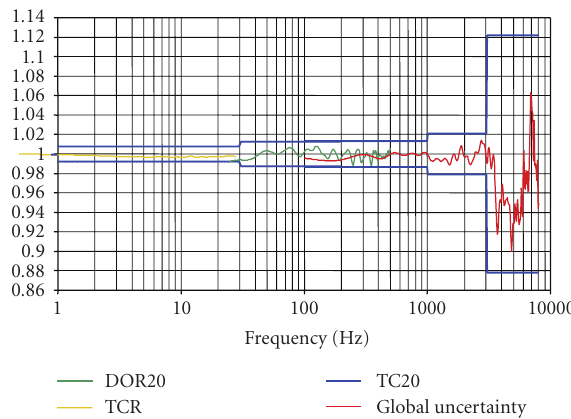
Figure 16: Measurement uncertainty against frequency.